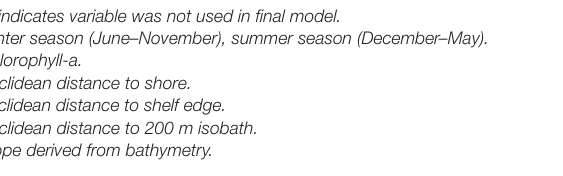
TABLE 6 | Model parameters and performance statistics of final models calculated from biomod2 package for R. Species